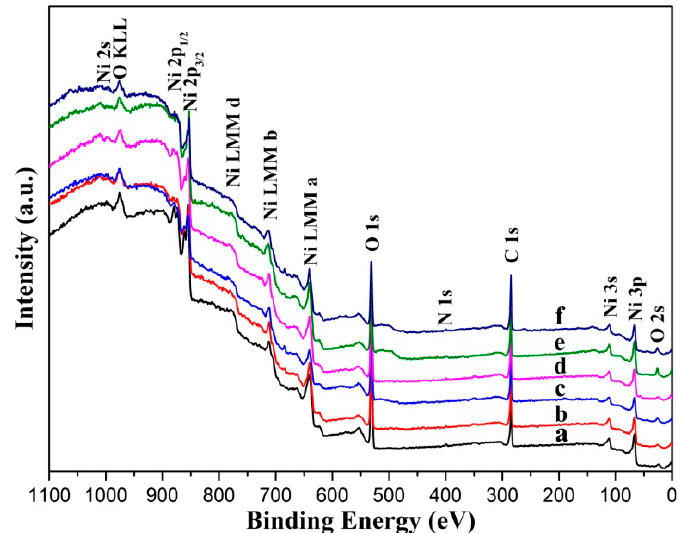
Figure 3. XPS survey spectra of the Ni surfaces: ( a ) untreated; ( b ) etched by HCl; ( c ) etched by H 2 SO 4 ; ( d ) etched by H 3 PO 4 ; ( e ) etched by HNO 3 ; and ( f ) etched by HF.